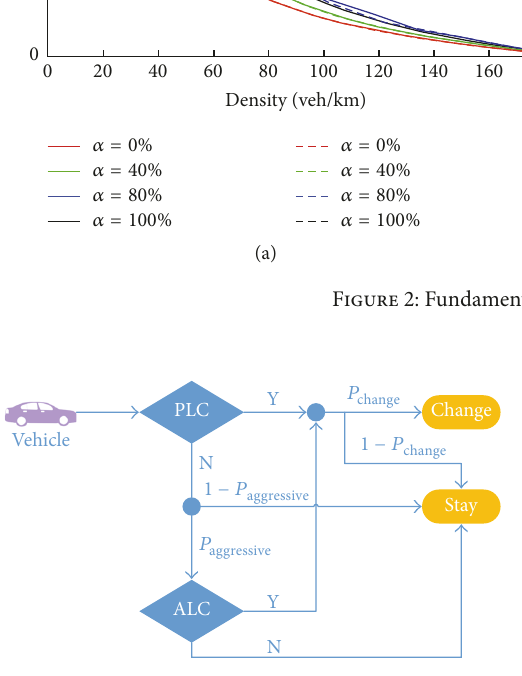
Figure 3: PLC or ALC for an